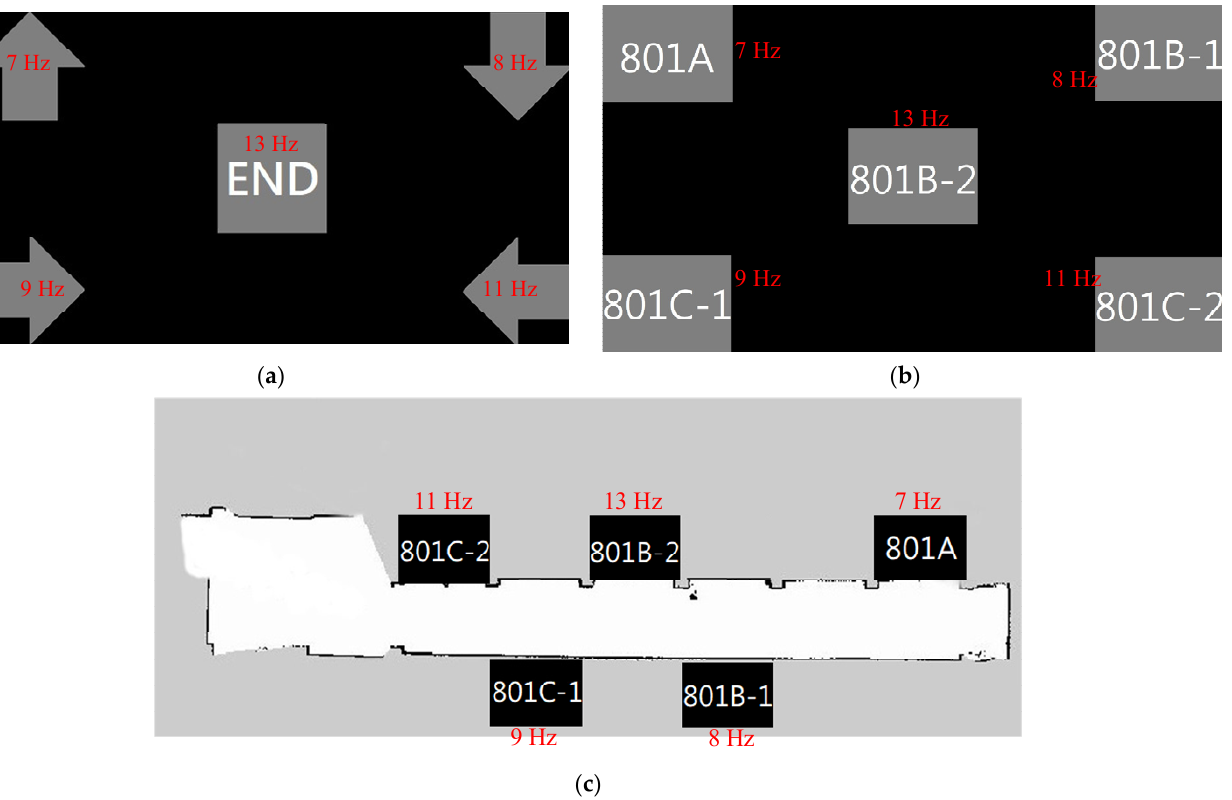
Figure 2. The three scenario configurations for this study: ( a ) Scenario 1 with four directions on the corners and an end choice in the middle of the black background, ( b ) Scenario 2 with five pieces of information of each room and ( c ) Scenario 3, where the map is constructed by the electric wheel-chair.